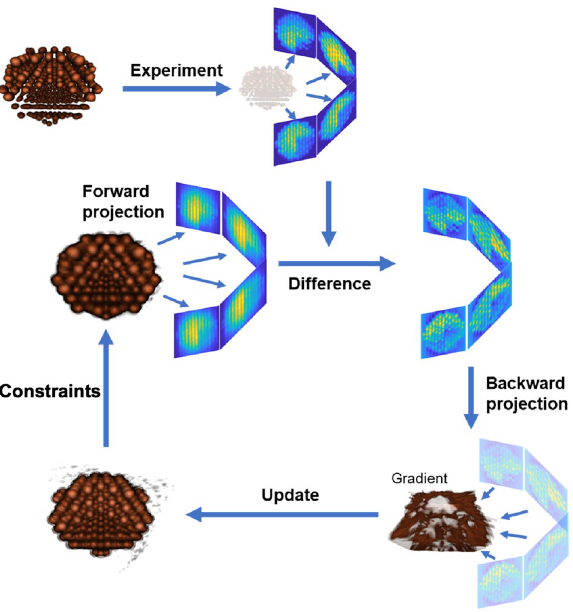
Figure 1. Schematic layout of the RESIRE algorithm. RESIRE first calculates the forward projections of an arbitrary initial object using FST or the Radon transform. The differences between the calculated and measured projections are back-projected to yield the gradient. The initial object is then updated using the gradient. Optional constraints such as positivity and support can be enforced for better convergence and accuracy. The updated object is used for the next iteration. Usually, after several hundreds of iterations, the algorithm